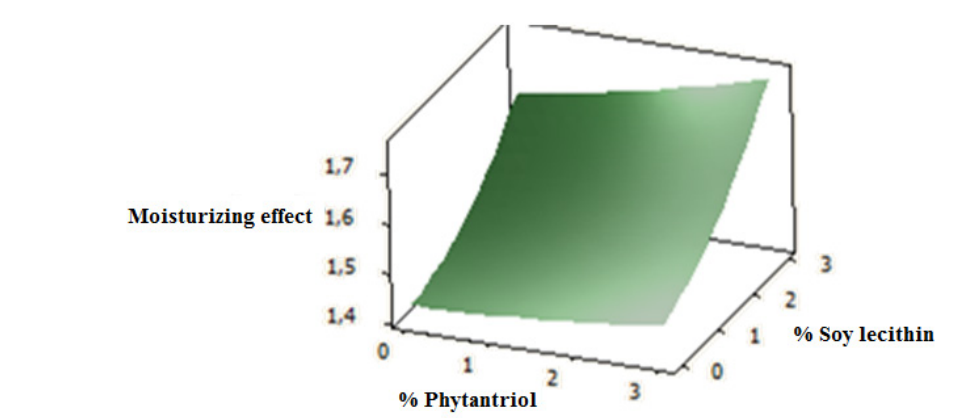
FIGURE 9 - Response surfaces for moisturizing effect (H), as a function of the factors: % phytantriol and % of soy